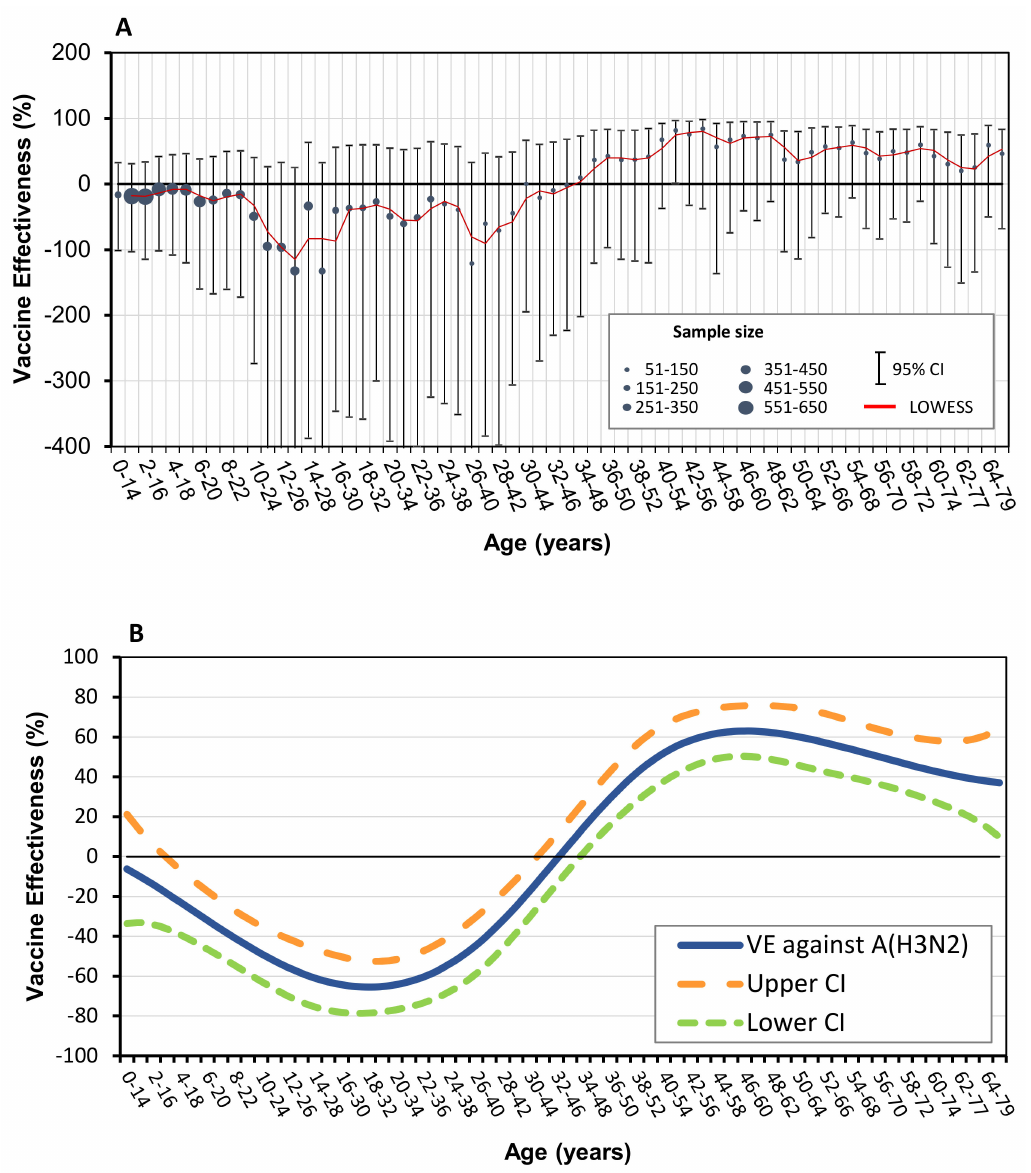
Figure 4. ( A ) Adjusted influenza A (H3N2) vaccine e ff ectiveness (VE) estimates, 2018-2019 season, by age, using moving age intervals of 15 years. Circles represent VE estimates and error bars represent 95% confidence interval (CI) of VE estimates. Solid line (red) represents locally weighted scatterplot smoothing (LOWESS) of dynamic VE point estimates. Circle sizes represent sample sizes. ( B ) Cubic spline applied to adjusted influenza A (H3N2) vaccine e ff ectiveness (VE), 2018-2019 season, using moving age intervals of 15 years. 95% confidence intervals of point estimates are